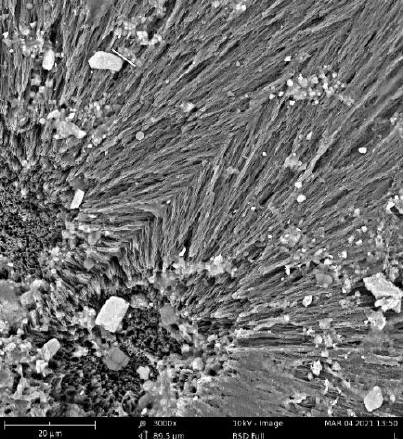
Figure 4. SEM image of PHB/eucalyptol 3% after 32 days of incubation.